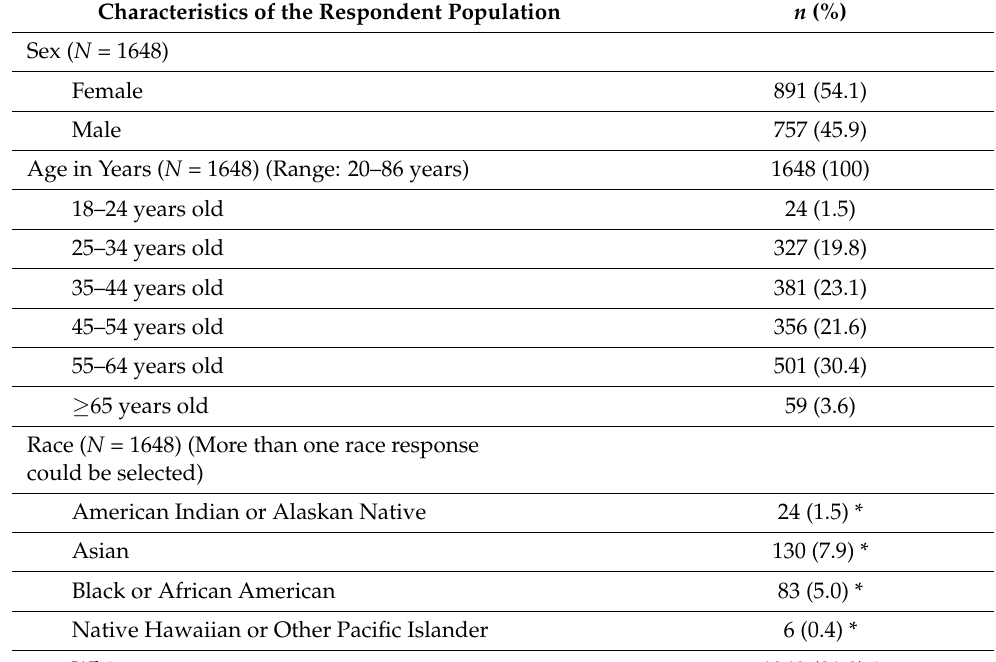
Table 1. Reported demographic and summary characteristics of survey